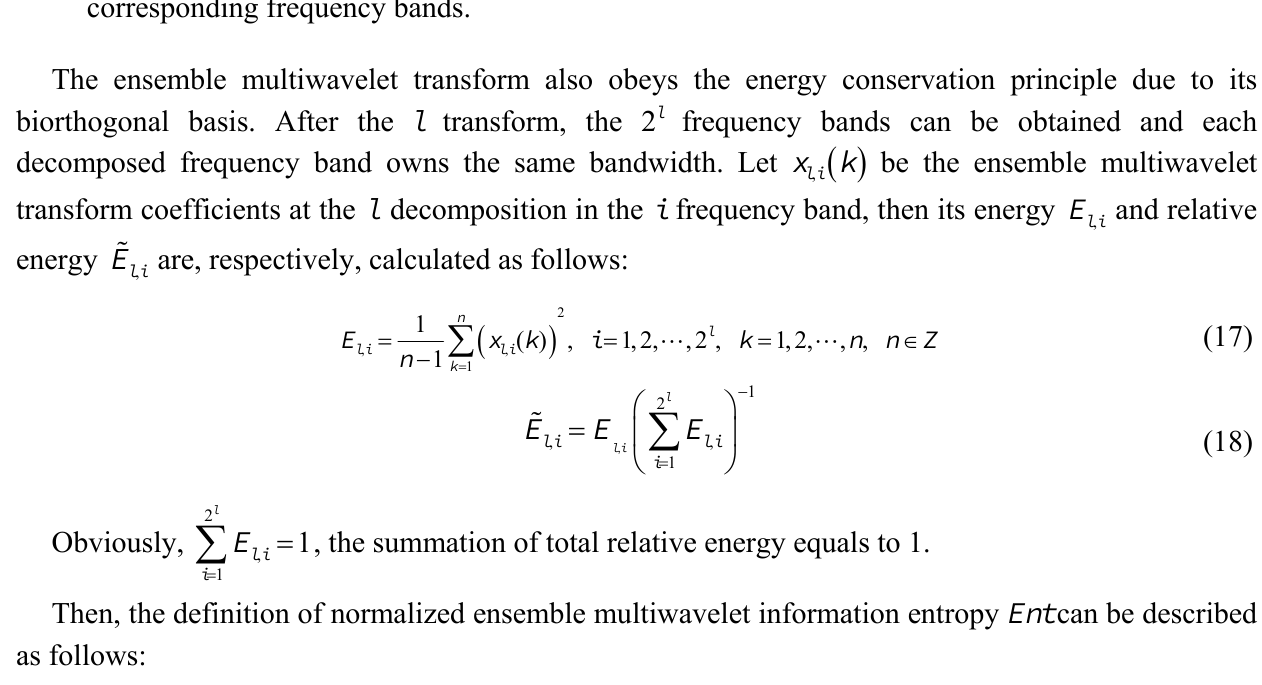
Figure 3. ( a ) The decomposition step of ensemble multiwavelet transform and ( b ) the corresponding frequency